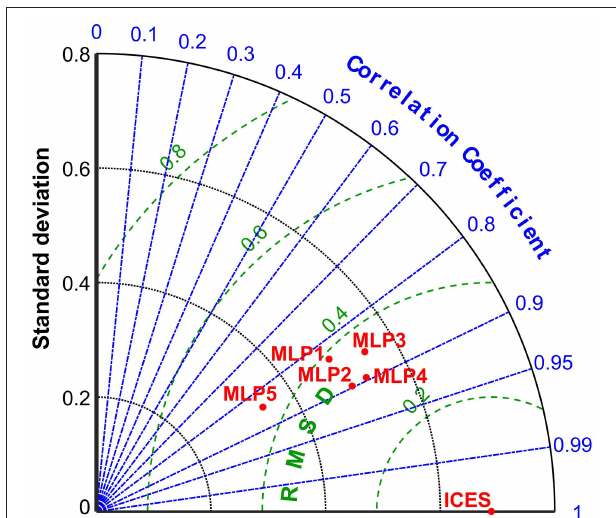
FIGURE 6 | Taylor diagram for multi-statistic model performance evaluation of the 5 MLP models in comparison to the ICES Age-2 numbers reference. RMSD—centered root mean square difference which is a variation of the mean square of errors used to train the MLP models. Correlation of determination here equivalent to the square root of r 2 reported in Table 2 . Standard deviation and RMSD units expressed on log